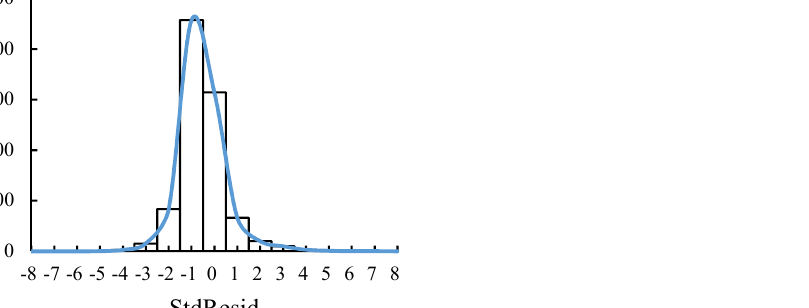
Figure 6. Distribution of the GWR model’s StdResid values in December, 2016.